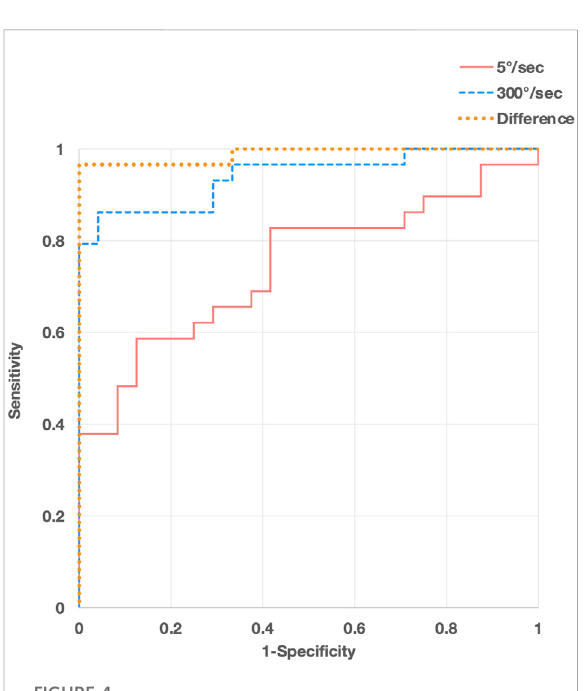
FIGURE 4 Receiver operating characteristic (ROC) curve analyses of peak resistance force values at angular velocities of 300 ° /s (blue, dashed line) and 5 ° /s (red, solid line) and their differences (orange, dotted line) for discriminating patients with spasticity from controls. 8.3 kg; maximum dorsi fl exion range, 31 ± 6 ° ) and 32 patients with stroke were enrolled. Of the 32 patients, 18 had cerebral hemorrhage, 11 had cerebral infarction, and 3 had subarachnoid hemorrhage. The distribution of the MAS score for the ankle